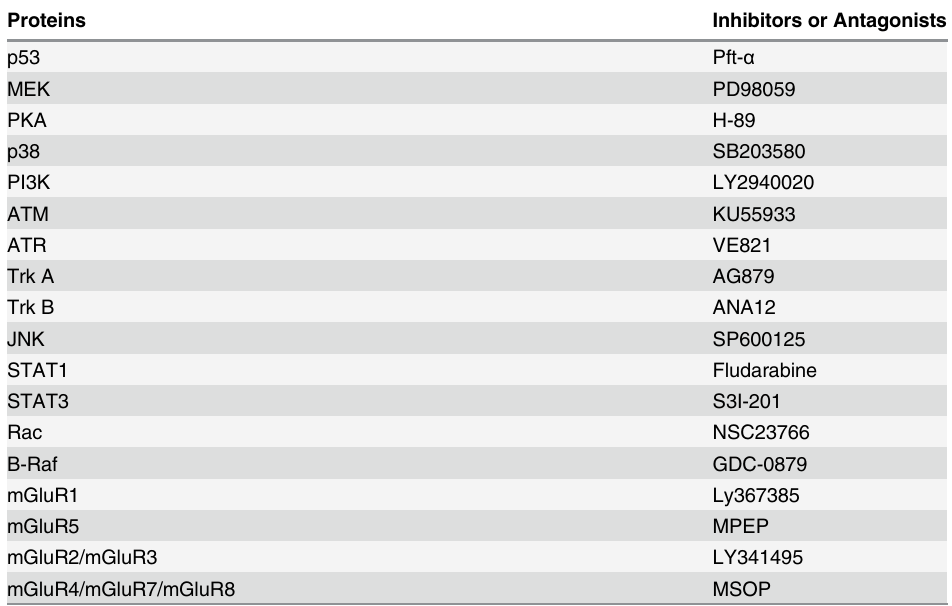
Table 1. Inhibitors or antagonists used in this